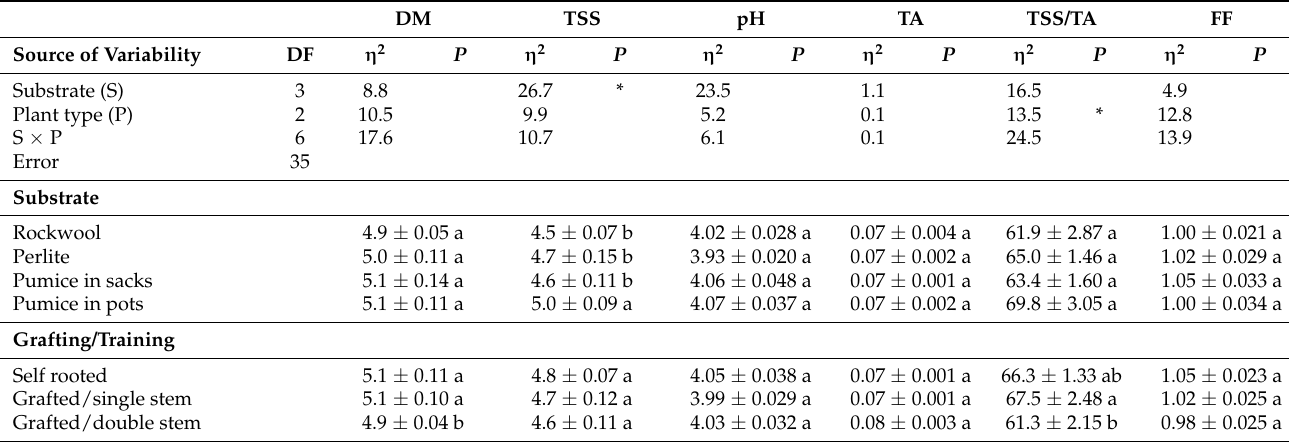
Table 7. Analysis of variance for average flavor quality traits (dry mass: DM, total soluble solids: TSS, titratable acidity: TA, flesh firmness: FF) of tomato fruit harvested on 6 June. The fruit was obtained from self-rooted ‘Beef Bang F1’, ‘Beef Bang F1’ grafted onto ‘Defensor’, trained in single or double stem and grown hydroponically in four substrates (rockwool slabs, perlite in sacks, pumice in sacks and pumice in pots) in a glasshouse.